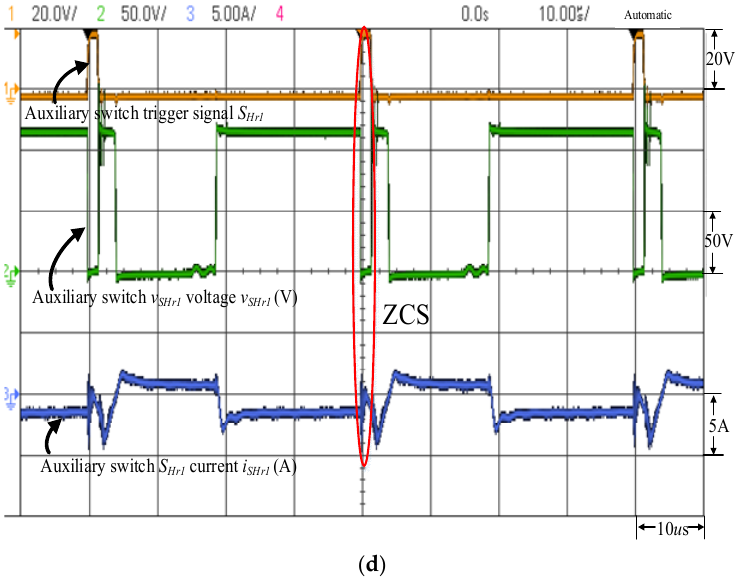
Figure 7. The actual test waveform for buck mode; the load is 300 W for each switch component: ( a ) main switch S L 1 ; ( b ) main switch S H 1 ; ( c ) auxiliary switch S Lr 1 ; ( d ) auxiliary switch S Hr 1.